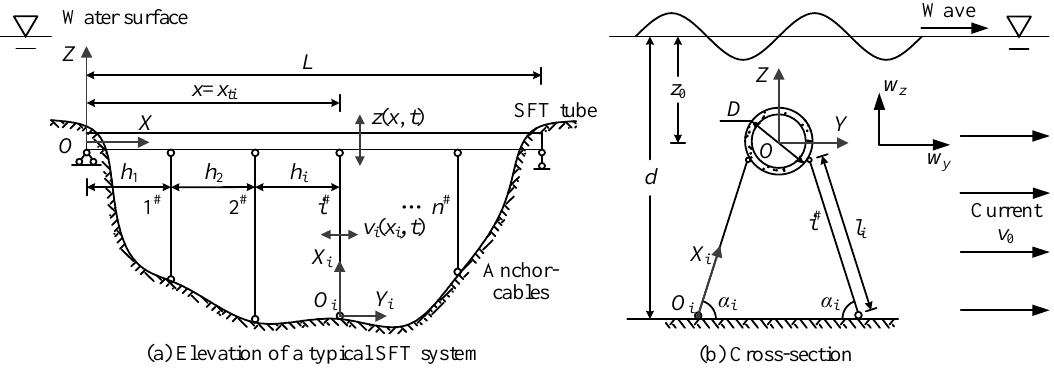
Figure 1. A typical submerged floating tunnel (SFT) tube-cable system in wave and current.